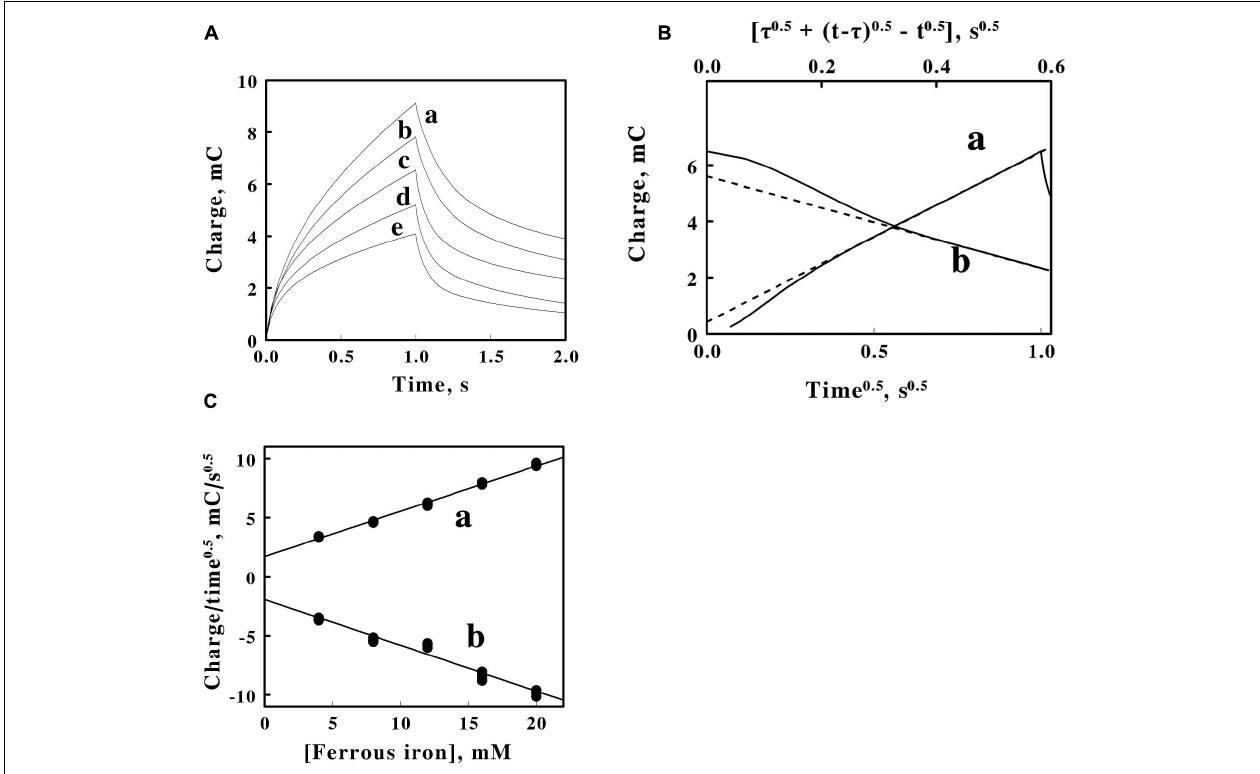
FIGURE 4 | Double potential step chronocoulometry on soluble iron in sulfuric acid, pH 1.5. (A) Charge vs. time responses obtained with 5 concentrations of equimolar ferric and ferrous sulfate: 20, 16, 12, 8, and 4 mM soluble iron for curves a–e , respectively. Each experimental curve of the charge as a function of time represents the mean of five individual determinations whose values varied by less than 1% among the five measurements. The increase in charge is a reduction step; the subsequent decrease in charge is an oxidation step. (B) Representative Anson plots for the reduction ( curve a, lower abscissa ) and the oxidation ( curve b, upper abscissa ) potential steps obtained using 12 mM iron, showing both the charge values ( solid curves ) and the slopes ( dashed lines ) used to characterize the latter portions of the charge curves; t and τ represent the time since the start of the measurement and the duration of the first potential step, respectively. (C) Dependence of the slopes extracted from Anson plots, such as those shown in B , on the concentration of soluble iron for the reduction ( curve a ) and oxidation ( curve b ) potential steps in A . Each datum in panel C represents the mean of five determinations. The standard deviation of each datum in curve a was within the area bound by the diameter of the datum. The standard deviation of the data at each concentration of soluble iron in curve b varied from 3 to